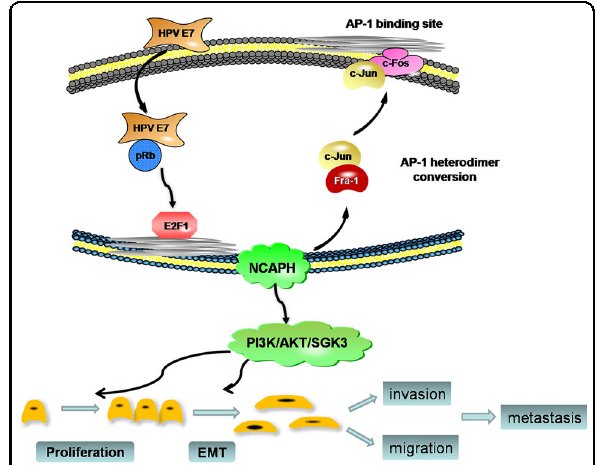
Fig. 8 Proposed model for the role of NCAPH in carcinogenesis of HPV-induced cervical cancer. HPV E7 upregulates the transcription factor E2F1 by degrading pRb, and E2F1 binds with the promoter of NCAPH to activate its transcription. Reversely, NCAPH enhances the expression of E7 by promoting the transformation of AP-1 components from Fra-1/c-Jun to c-Fos/c-Jun. Overexpressed NCAPH promotes the development and progression of cervical cancer by the enhancement of proliferation, invasion and